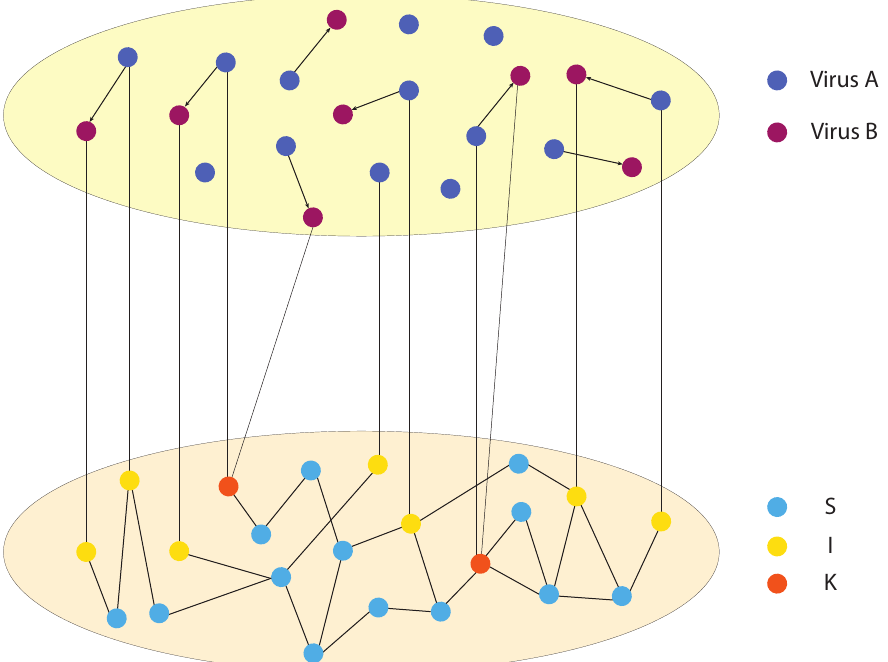
Figure 1. The upper layer presents viruses in the environment. Virus A (blue node) can evolve into virus B (red node) in the body, as indicated by directed links. In the lower layer, nodes represent people and links represent contact: S (blue node) is susceptible, I (yellow node) is infected, and K (orange node) represents people with two virus pathogens. A link between the two layers means that a person has been infected by the corresponding